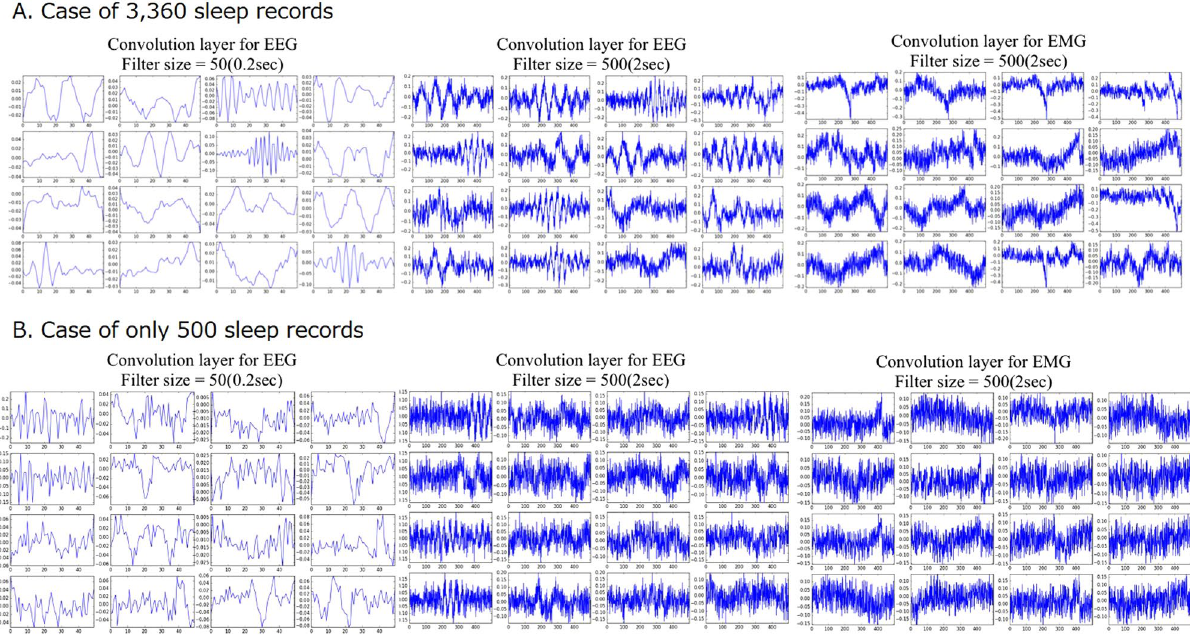
Figure 5. Example of extracted features by feature extraction module of MC-SleepNet. (left) EEG features extracted by narrow CNN. (center) EEG features extracted by wide CNN. (right) EMG